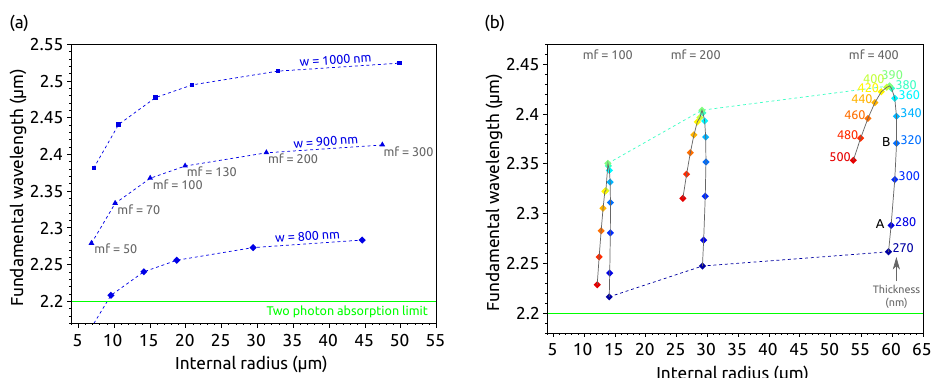
Figure 2. Fundamental wavelengths and geometries fulfilling the requirements for the SHG in a Si microring cladded by Si 3 N 4 for p f = 1, p SH = 3, a Hz fundamental mode, and a Ez SH mode. ( a ) For a fixed thickness e = 280 nm and three different widths w . The points correspond to different fundamental azimuthal numbers m f . ( b ) For a fixed width w = 800 nm and different thicknesses represented by the different colored points. The three curves correspond to different m f